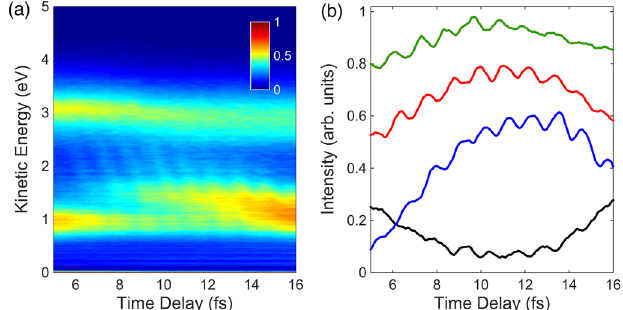
FIG. 3. (a) Time-dependent N þ kinetic energy spectra acquired within the pump-probe delay interval 5 – 16 fs. (b) N þ yield integrated in a 0.3-eV-wide energy band around 0.8 eV (black curve), 1.6 eV (blue curve), 1.9 eV (red curve), and 2.2 eV (green curve). An arbitrary offset has been added to the curves for better visualization.